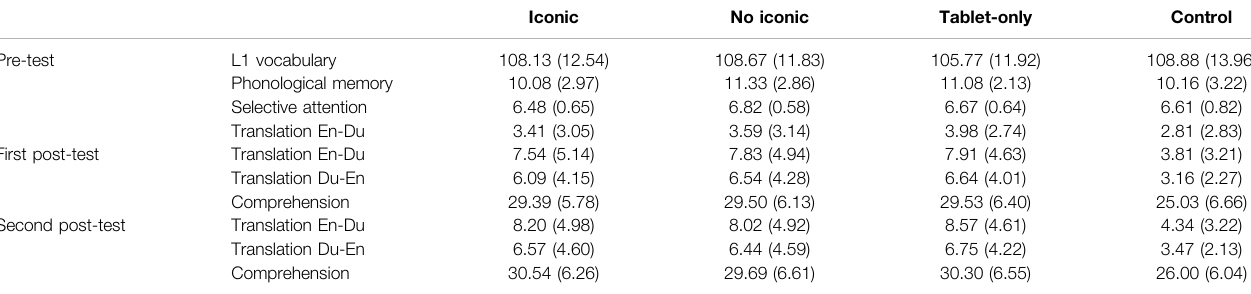
TABLE 3 | Means (standard deviation) on all the tasks in the pre-test and post-tests for the four conditions. Iconic No iconic Tablet-only